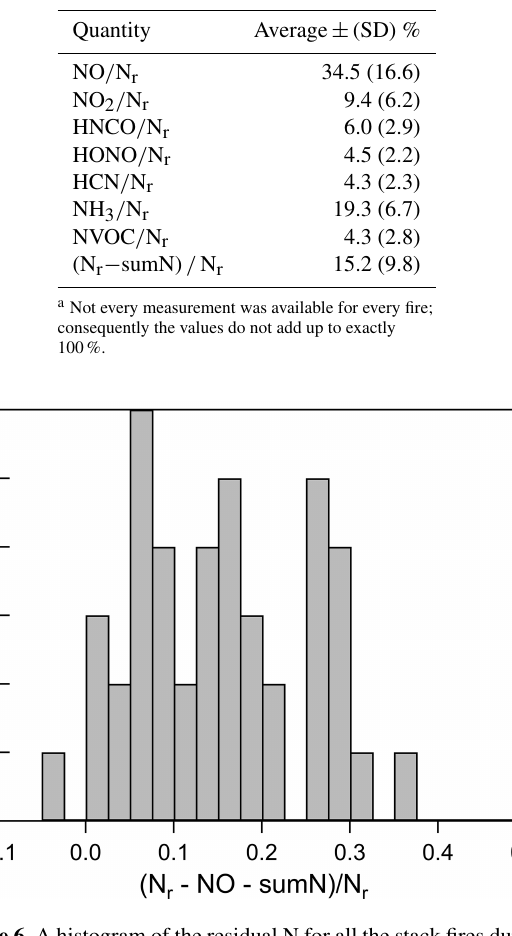
Figure 6. A histogram of the residual N for all the stack fires during the 2016 Fire Lab study for which there are FTIR, ACES, and PTR- ToF measurements ( n = 43). The median is 0.143, and the mean ( ± SD) was 0.15 ( ± 0 .